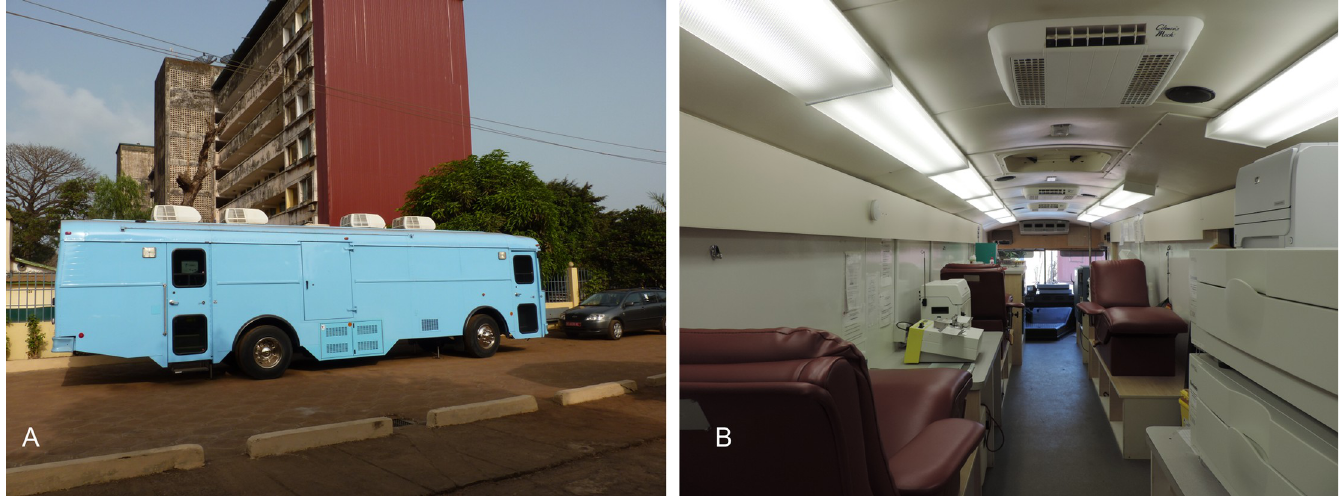
Fig 1. ‘Le bus’. The exterior (a) and interior (b)